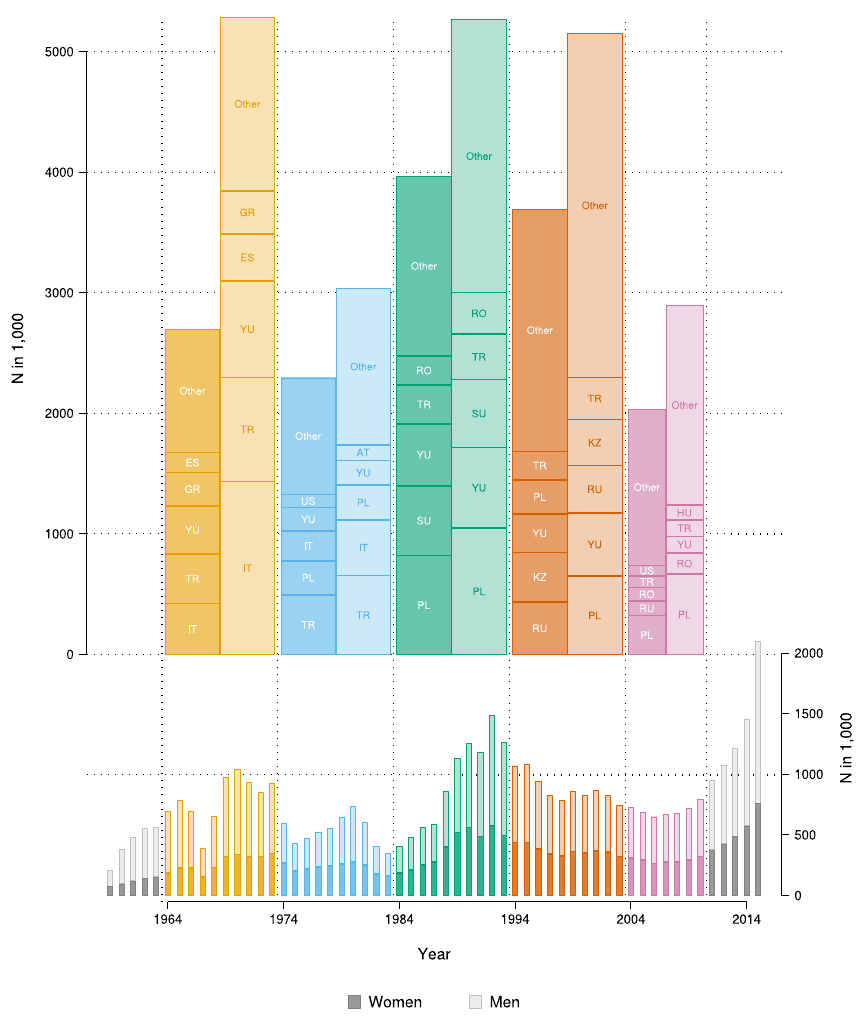
Figure 1 : Immigrant inflows into Germany by year and gender (lower panel). Citizenship composition of arrival cohorts by gender (upper